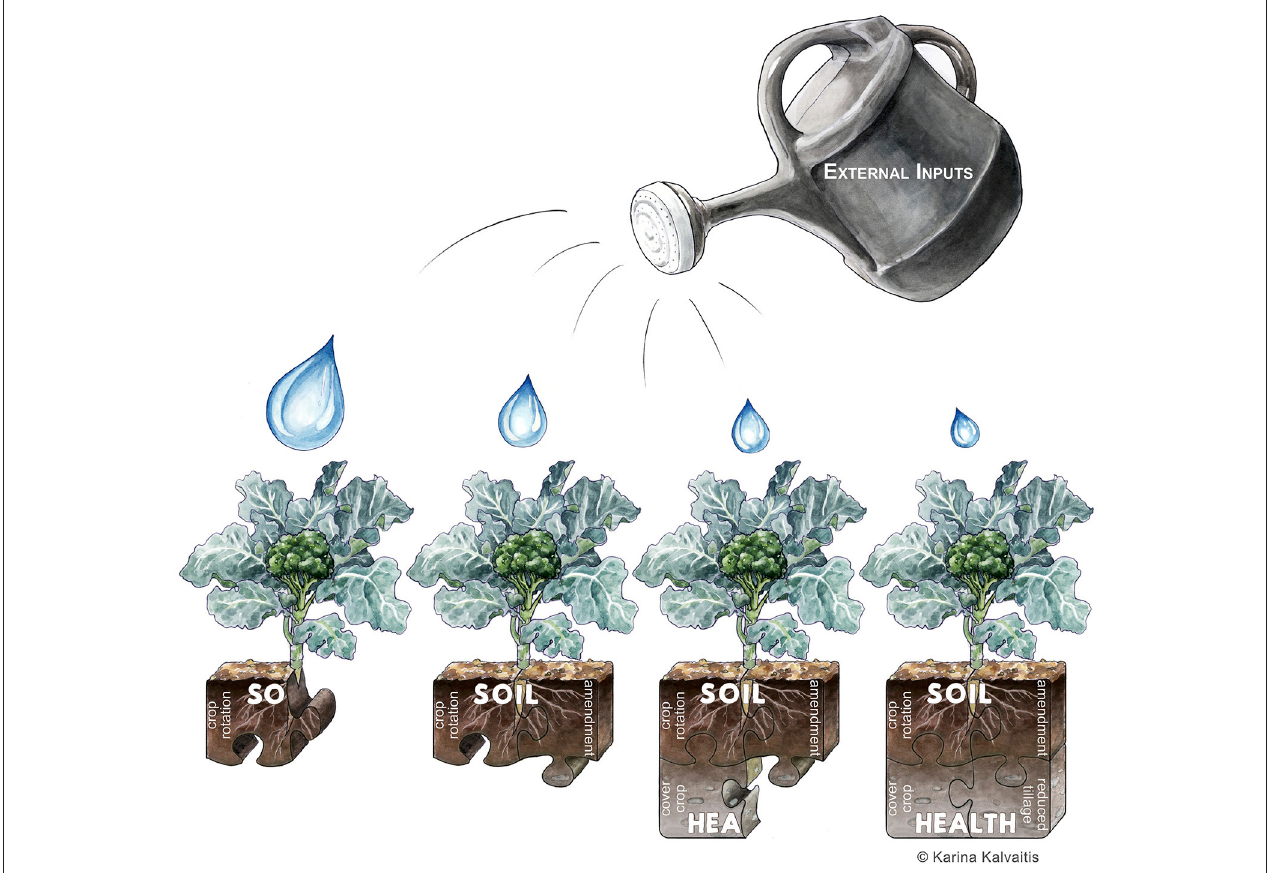
FIGURE 4 | Conceptual model toward improved soil health in intensive vegetable cropping systems. Published with permission from